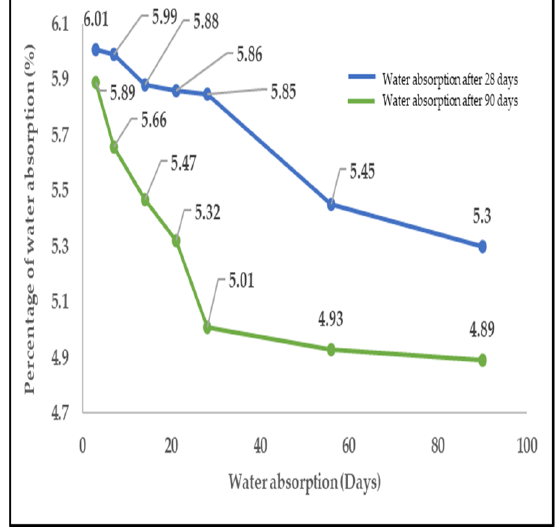
Figure 14. Variation in water absorption of SRMBs after 28 and 90 days of curing.